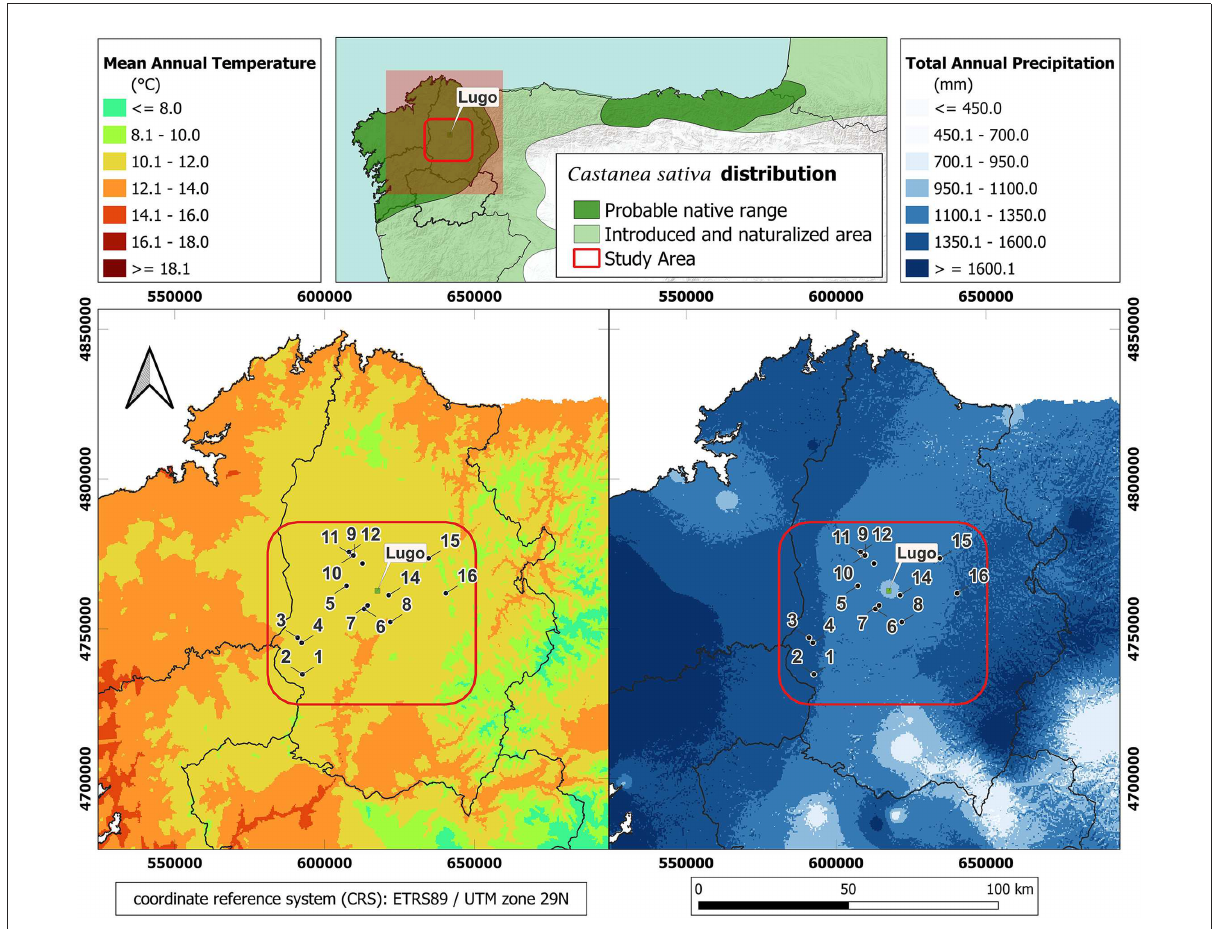
FIGURE1 Spatial distribution of the 16 study plots superimposed on the mean values of mean annual temperature and total annual precipitation. Source: Ninyerola et al.